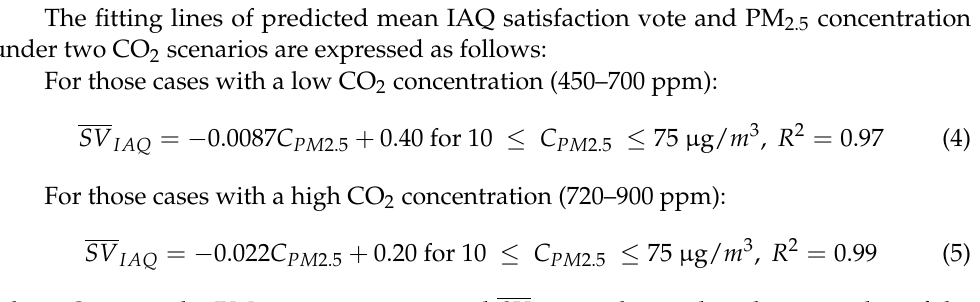
Figure 7. The relationship between mean IAQ satisfaction vote and PM 2.5